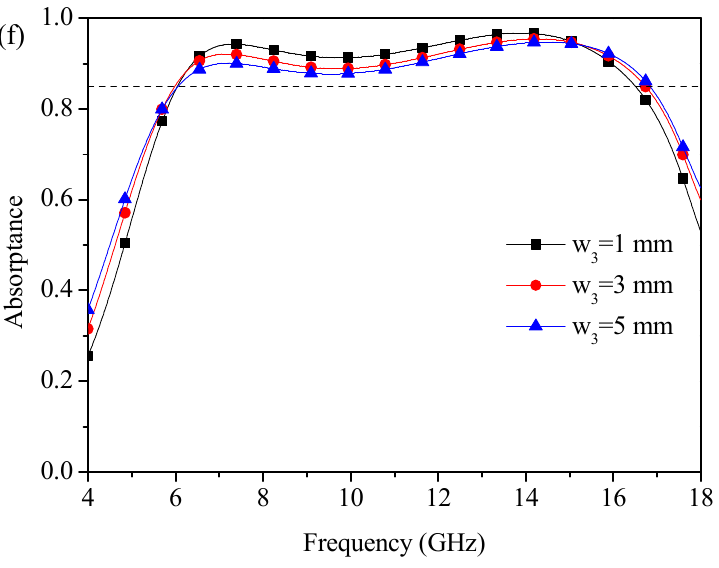
Figure 5. Absorption performance of the absorber for different geometric dimensions: ( a ) varied d 2 ; ( b ) varied d 3 ; ( c ) varied R 2 ; ( d ) varied R 3 ; ( e ) varied w 2 ; ( f ) varied w 3 .